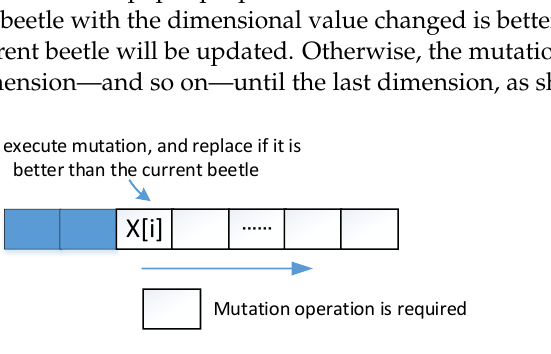
Figure 1. Variation diagram of single beetle in high-dimensional case.